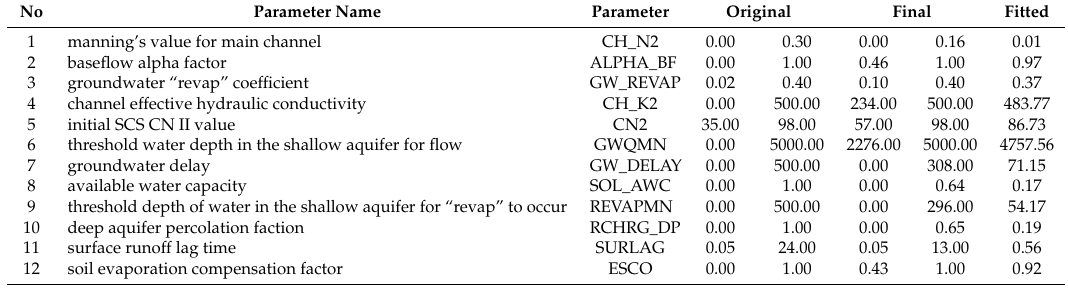
Table 2. Soil and Water Assessment Tool (SWAT) parameters (*1 most sensitive based on final range).